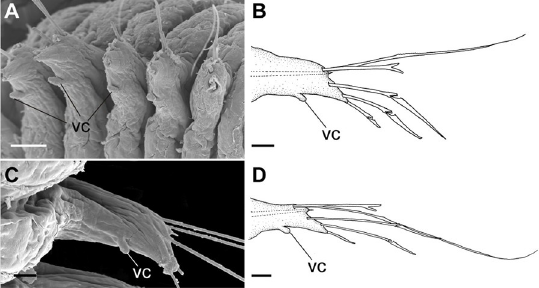
Fig 15. Meiodorvillea hartmanae sp. nov. (A,B) parapodia from anterior region, (A) ventrolateral view, (B) anterior view; (C,D) parapodia from posterior region, (C) ventral view, (D) anterior view. Abbreviations: vc = ventral cirrus. Scale bars: (A) = 20 μ m; (B,D) = 15.6 μ m; (C) = 10 μ m.